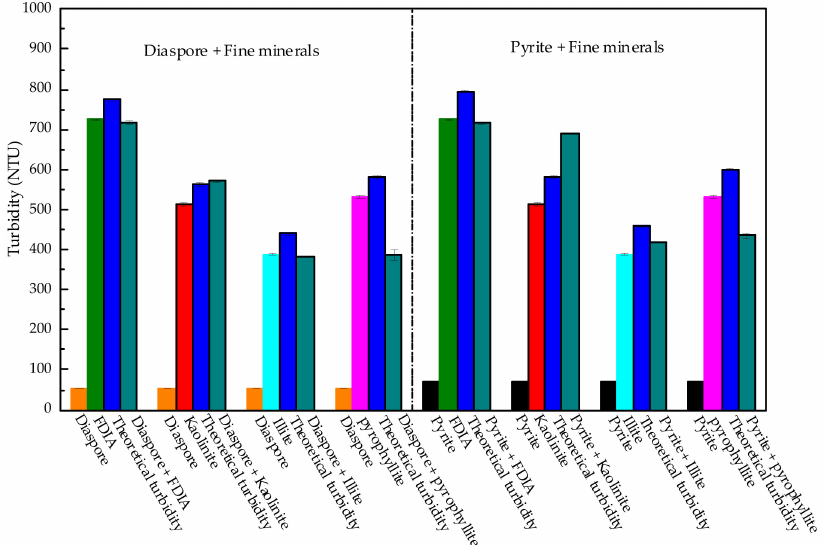
Figure 12. Turbidity of mixture of fine minerals and diaspore or